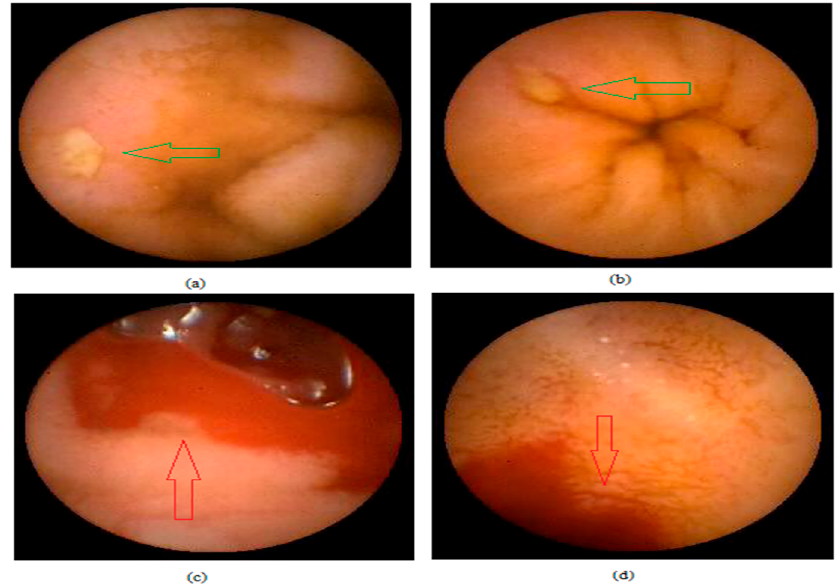
Figure 1. WCE images with bleeding and ulcer. ( a , b ) Ulcer image; and ( c , d ) bleeding images.